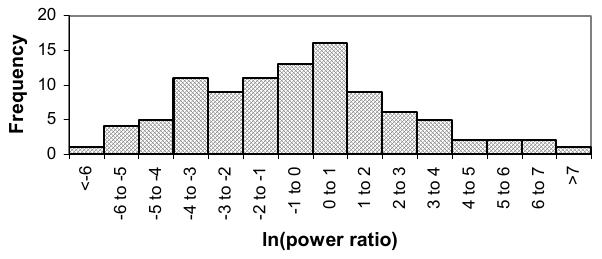
Fig. 3. Histogram showing frequency of occurrence of ln of power ratios obtained when enhanced spectra occurred in the 1 and 2 De- cember 1999 ESR, GUP3